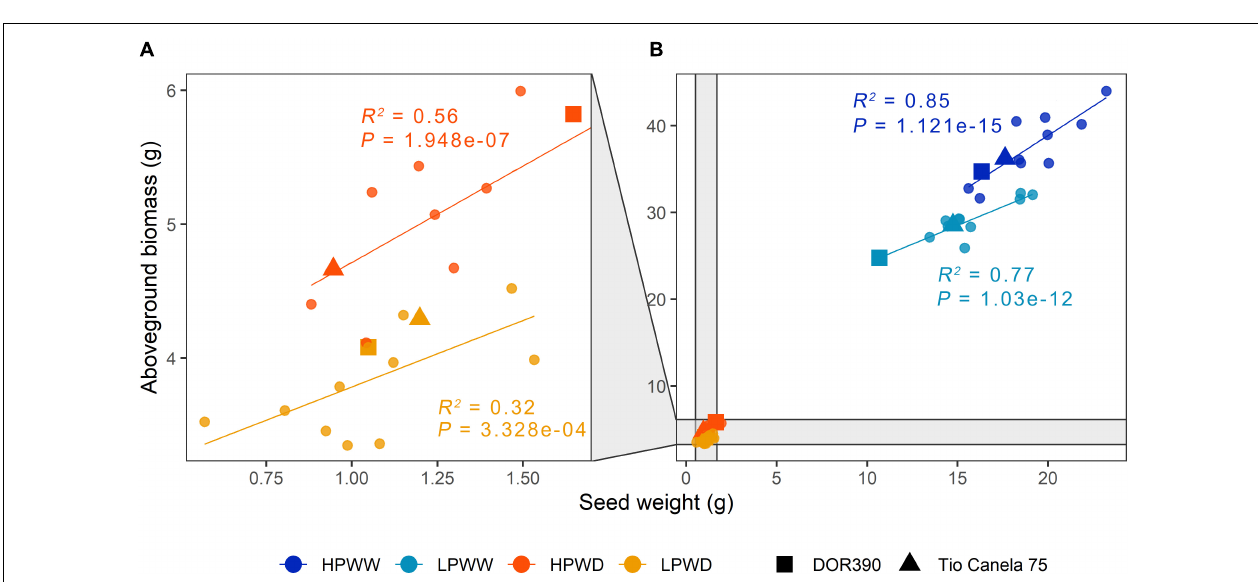
FIGURE 2 | Seed weight (g) and aboveground biomass (g) for 12 common bean lines under different treatments. (A) High phosphorus water deficit (HPWD; orange) and low phosphorus water deficit (LPWD; light orange). (B) High phosphorus well-watered (HPWW; blue) and low phosphorus well-watered (LPWW; light blue). Standard errors have been removed for clarity ( n = 3). Linear regression to calculate adjusted R 2 and P values grouped according to treatment. Commercial checks are illustrated by square and triangle shapes.